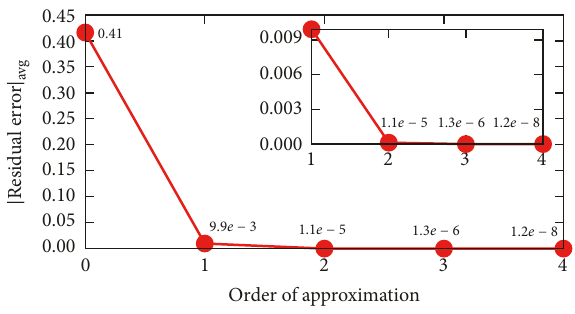
Figure 4: Convergence of HPLM.